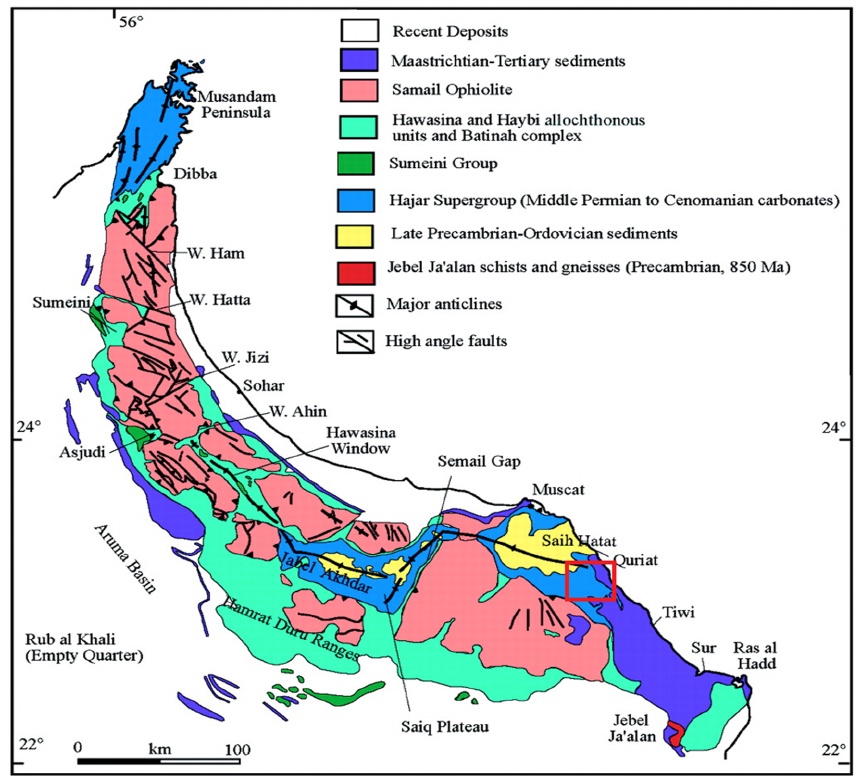
Figure 2. A simplified geological map of northern Oman that shows major formations and structures on a regional scale, including Quriat and the study area (modified after [20]). They are composed of several major units, ranging in age from Precambrian to Miocene.